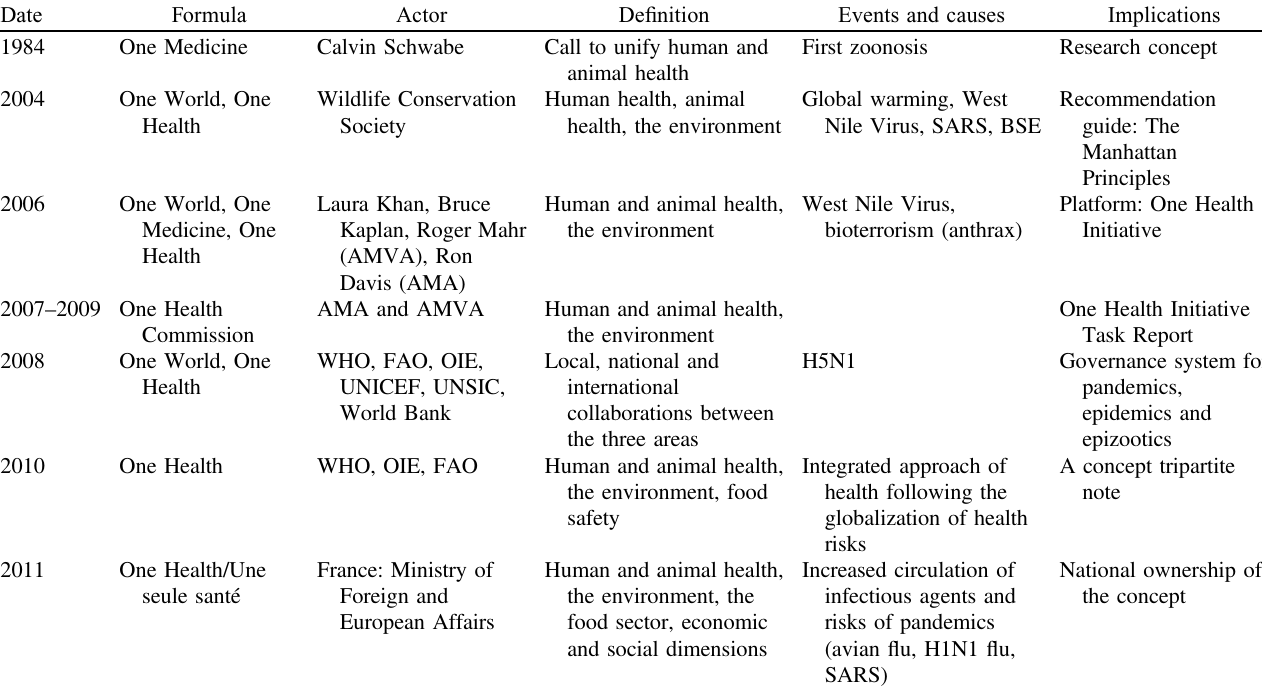
Table 1. The trajectory of One Health : formulas and de fi